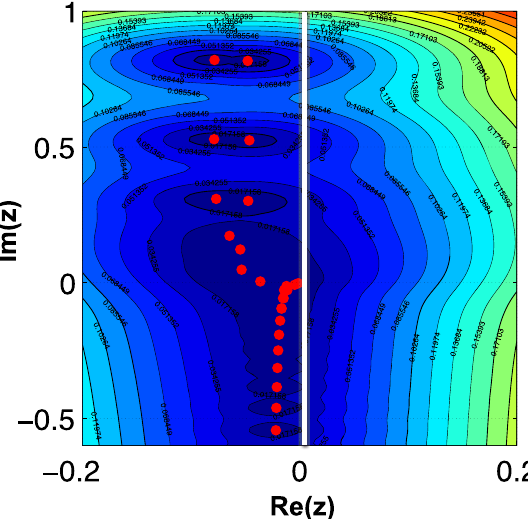
FIG. 10. Contour plots of different ϵ pseudospectra in the complex plane of the non-normal potential shown in Fig. 1(b), for g ¼ 1 . The red dots depict the eigenvalue